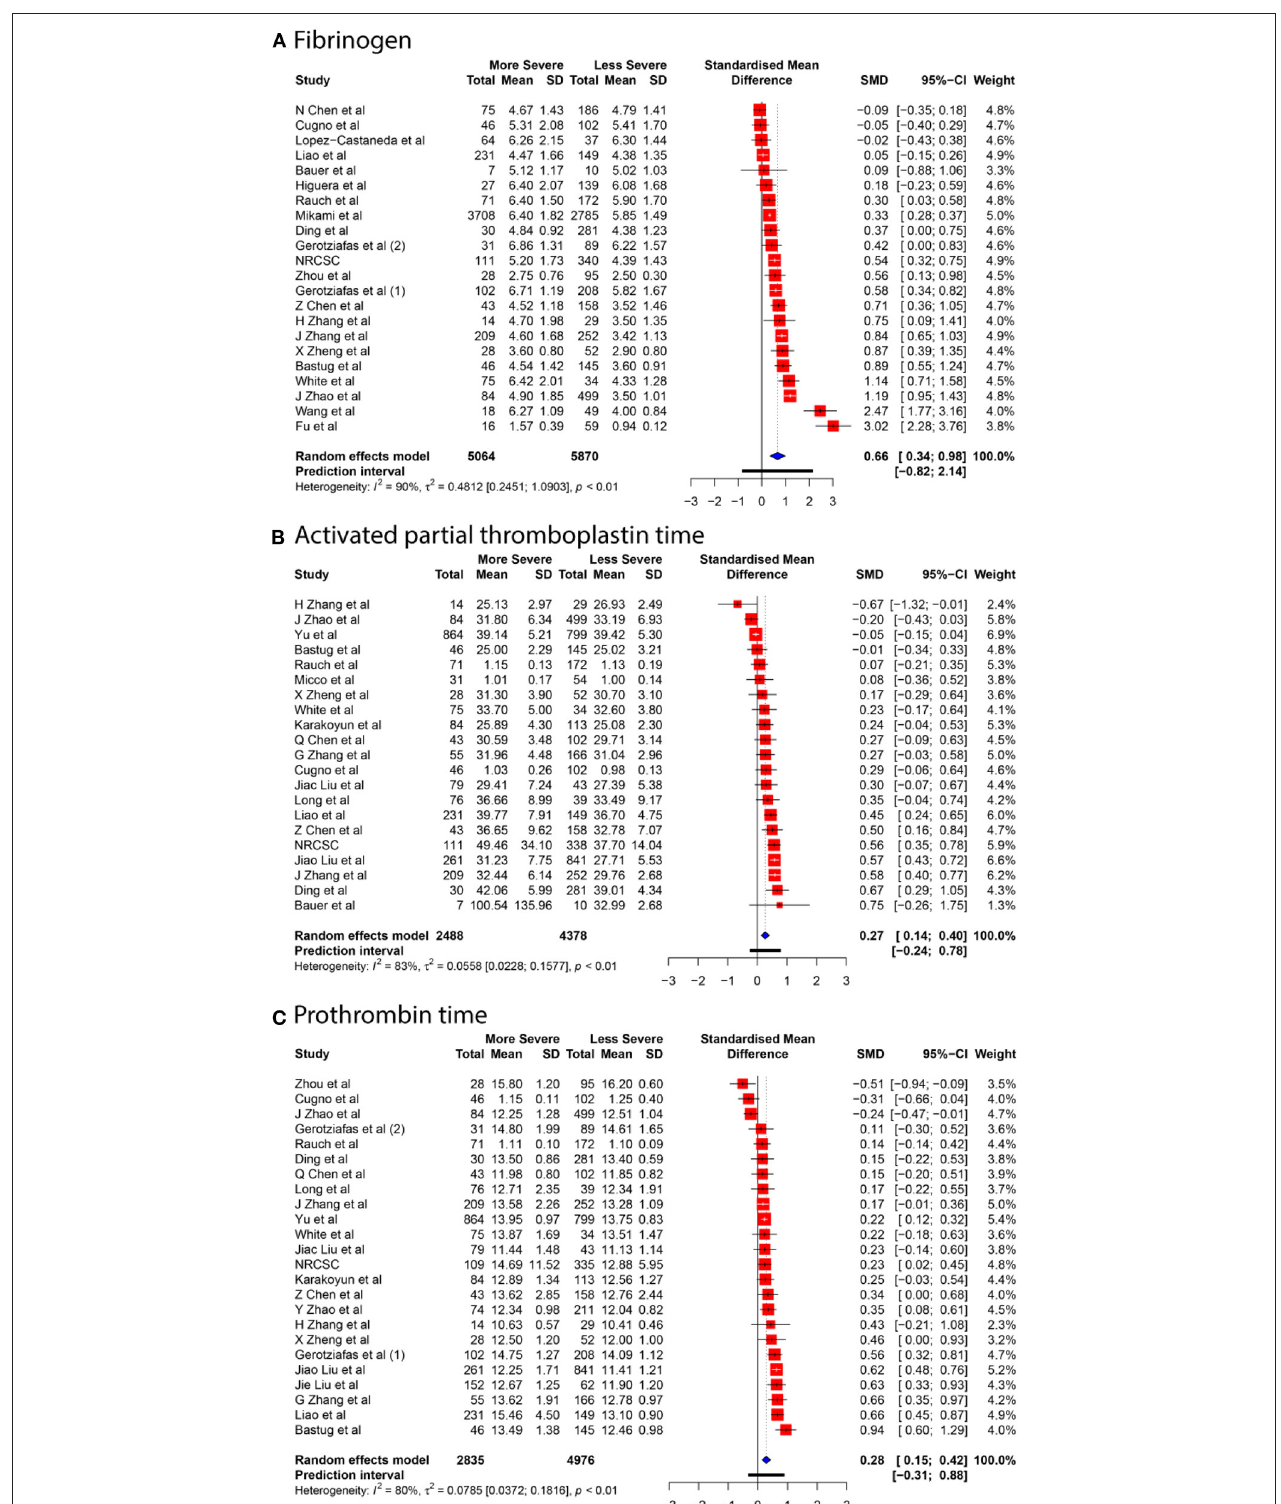
FIGURE 4 | Forest plots of the association between COVID-19 severity and (A) FIB, (B) APTT, (C) PT.